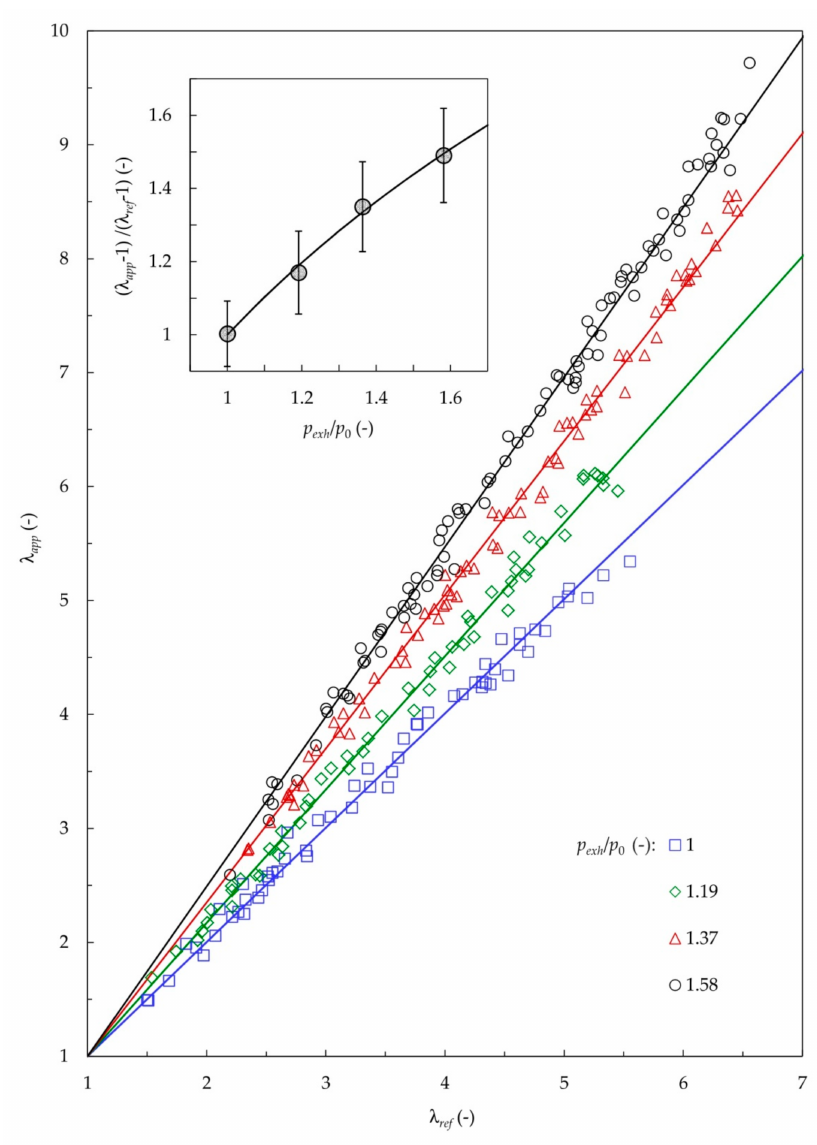
Figure 6. λ app vs. λ ref for di ff erent exhaust pressures. The graph inside presents the directional coe ffi cient of linear fit, where error bars denote standard deviations of the residual